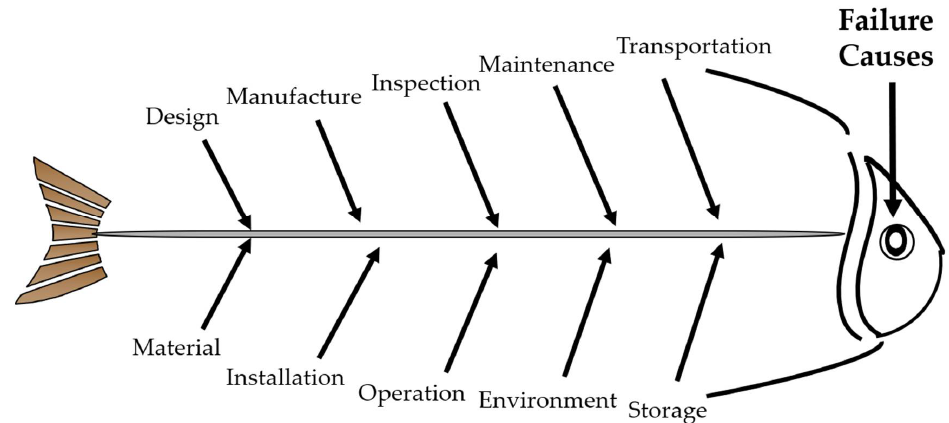
Figure 2. The fishbone diagram of failure analysis for engineering equipment.